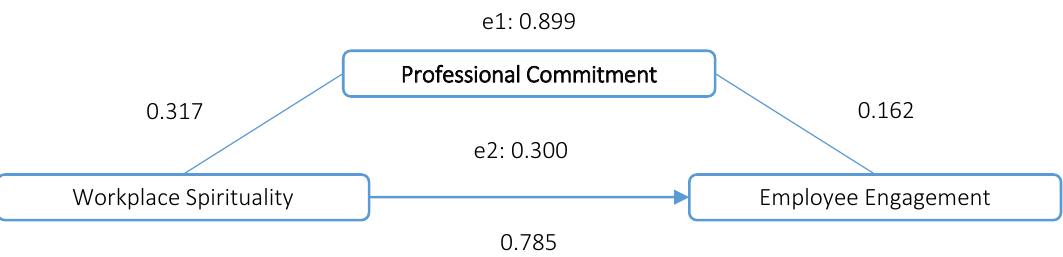
Figure 2. Mediation model of workplace sprituality and employee engagement using professional commitment as a mediating